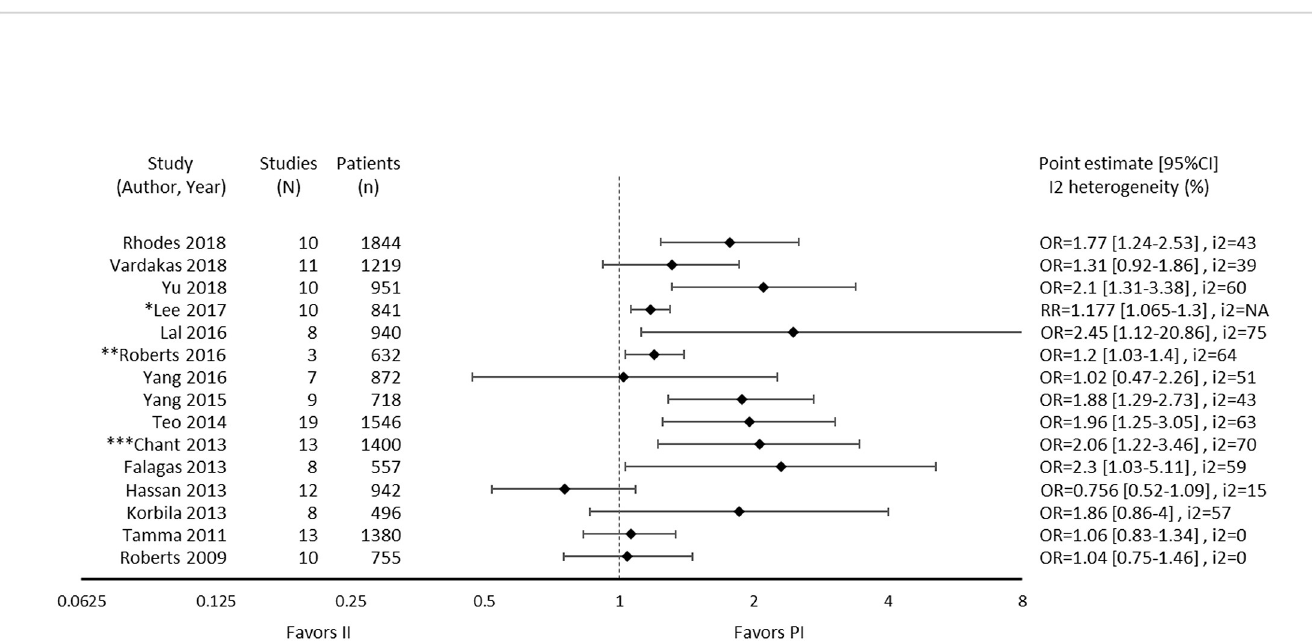
Fig 7. Effect of prolonged versus intermittent infusions of beta-lactam antimicrobials on clinical cure. � Lee 2017 –Did not report event rates. RR was therefore not converted to OR. �� Roberts 2016 –individual patient data meta-analysis. ��� Chant 2013 –reported treatment failure. RR = 0.60 [0.40–0.87], I 2 = 69%. Results were inverted to represent clinical cure or